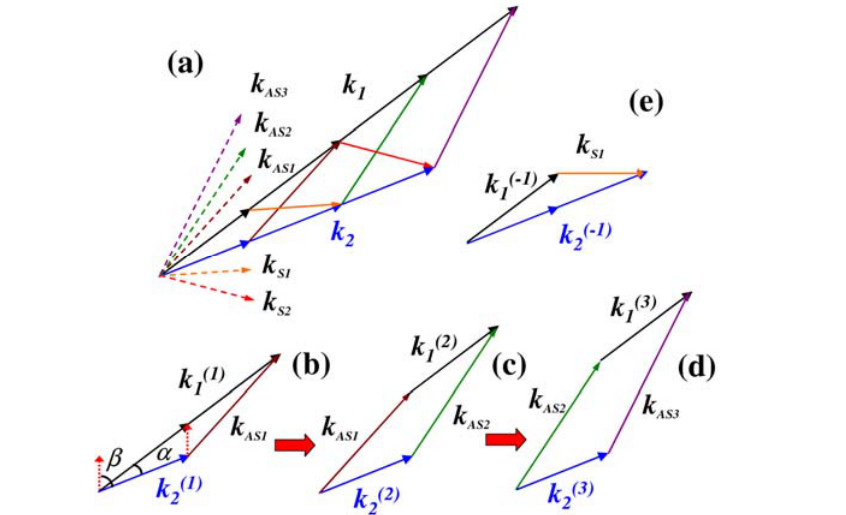
Figure 1. (a) Phase-matching geometry for CFWM process. Phase-matching geometries for generating (b) AS1, (c) AS2, (d) AS3, and (e) S1. k The angle α is the crossing angle between the two input beams in the medium